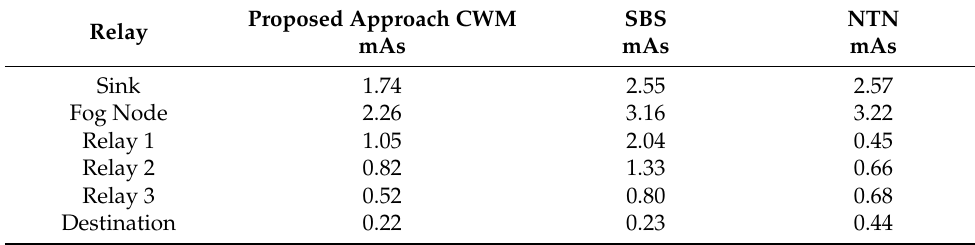
Table 6. Single nodes energy consumption using 3